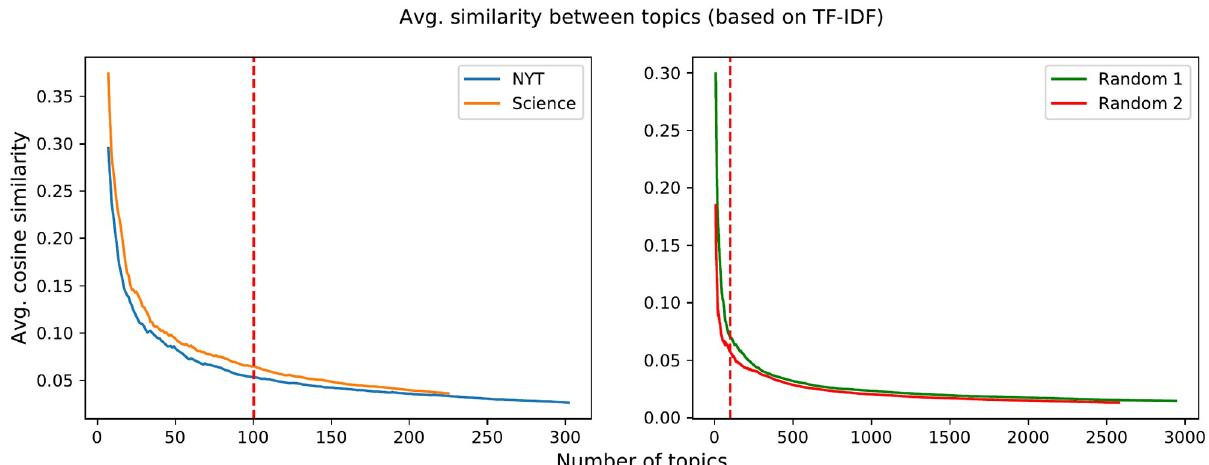
Fig 11. Semantic profile illustration. Each ring is associated with a topic distribution. Note : Two different semantic profiles can be built, depending on whether topics are assigned using hard vs soft clustering. In S1 Appendix we show that the use of soft clustering (and thus the inclusion of outliers) does not improve the reliability of the analysis. It gives too much importance to noisy data which favors the emergence of very generalized “super topics” that dominate all semantic profiles. We, therefore, present in Section 5.3 only the results obtained with hard clustering. In S1 Appendix we discuss soft versus hard clustering in detail and motivate why hard clustering is better suited for our